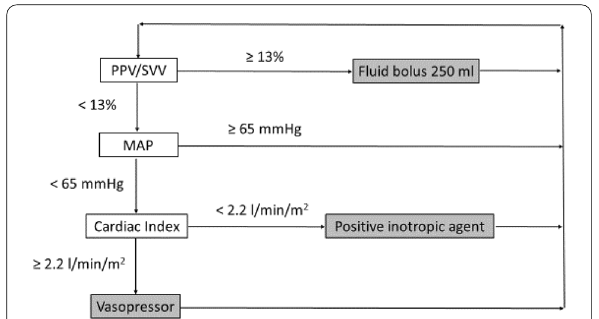
Fig. 1 Typical intraoperative goal‑directed therapy algorithm based on an individualized approach. MAP mean arterial pressure, PPV pulse pressure variation, SVV stroke volume variation. Values for PPV/SVV, MAP and cardiac index are indicative and must be adapted on an individual basis. The use of vasopressors could also be considered when diastolic arterial pressure < 40